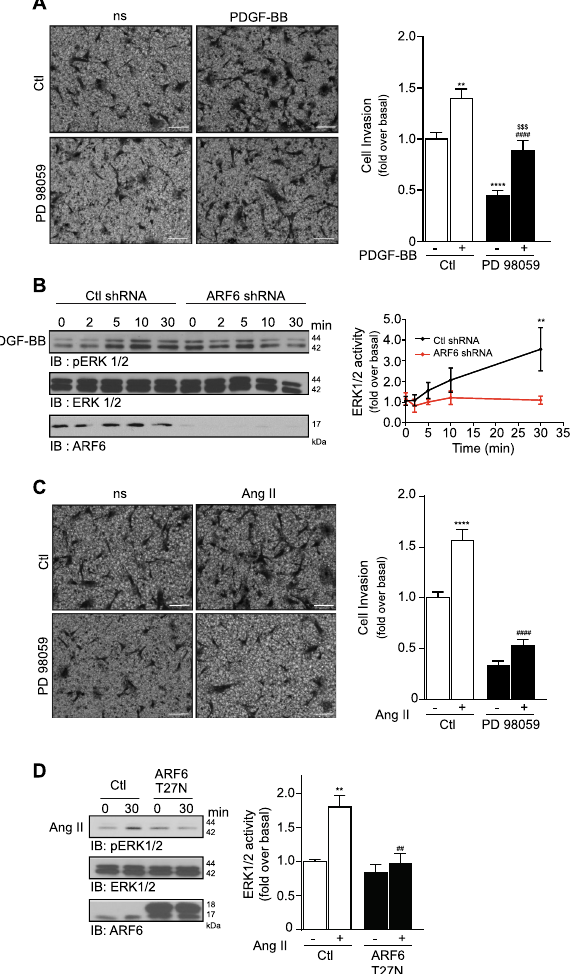
Figure 4. The MAPK pathway controls PDGF-BB and Ang II-dependent invasion and is regulated by ARF6. ( A ) 100 000 HASMC cells were seeded into Matrigel-coated Boyden chambers and pretreated with DMSO (Ctl) or PD98059 (25 µM) for 1 h. One set of cells was left untreated (non-stimulated; ns) and the other was stimulated with PDGF-BB (25 ng/mL) for 24 h. Images are from the lower part of the membrane and are representative of five images taken per condition. Quantifications are the mean ± SEM realised on five independent experiments. ****P < 0.0001 are values compared to basal condition, #### P < 0.0001 compared to Ctl PDGF-BB, $$$ P < 0.001 compared to PD98059 ns (Two-Way Anova) (bar = 100 µm). ( B ) Cells were infected with a Ctl or ARF6 shRNA and then serum starved 16 h before stimulation with 25 ng/mL of PDGF-BB for 0, 2, 5, 10 and 30 min. Cells were lysed and ERK1/2 activity was assessed by Western blotting using specific antibodies. Quantifications are the mean ± S.E.M. of three independent experiments. **P < 0.01 (Two-Way Anova). ( C ) Cells were seeded and pretreated as in ( A ). After 1 h, one set of cells was left untreated (non- stimulated; ns) and the other was stimulated with Ang II (100 nM) for 24 h. Images are from the lower part of the membrane and are representative of five images taken per condition. Quantifications are the mean ± SEM realised on six independent experiments. ****P < 0.0001 are values compared to basal condition, #### P < 0.0001 compared to Ctl Ang II (Two-Way Anova) (bar = 100 µm). ( D ) Cells were transfected with a Ctl or ARF6 T27N DNA plasmid using Lipofectamine 3000 according to the manufacturer’s instructions and serum starved before stimulation with Ang II for 30 min. Cells were lysed and ERK1/2 activity was assessed by Western blotting using specific antibodies. Quantifications are the mean ± SEM of three independent experiments. **P < 0.01 are values compared to basal condition, ## P < 0.01 compared to Ctl Ang II (Two-Way